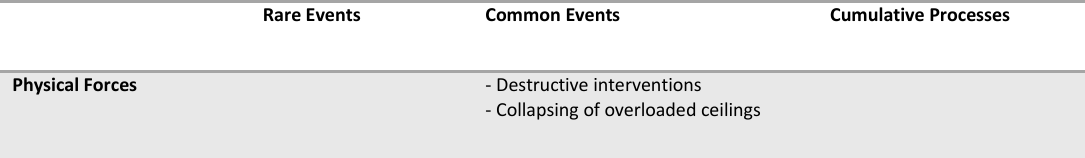
Table 1 Risk agents in Kirkuk Citadel considering the types of